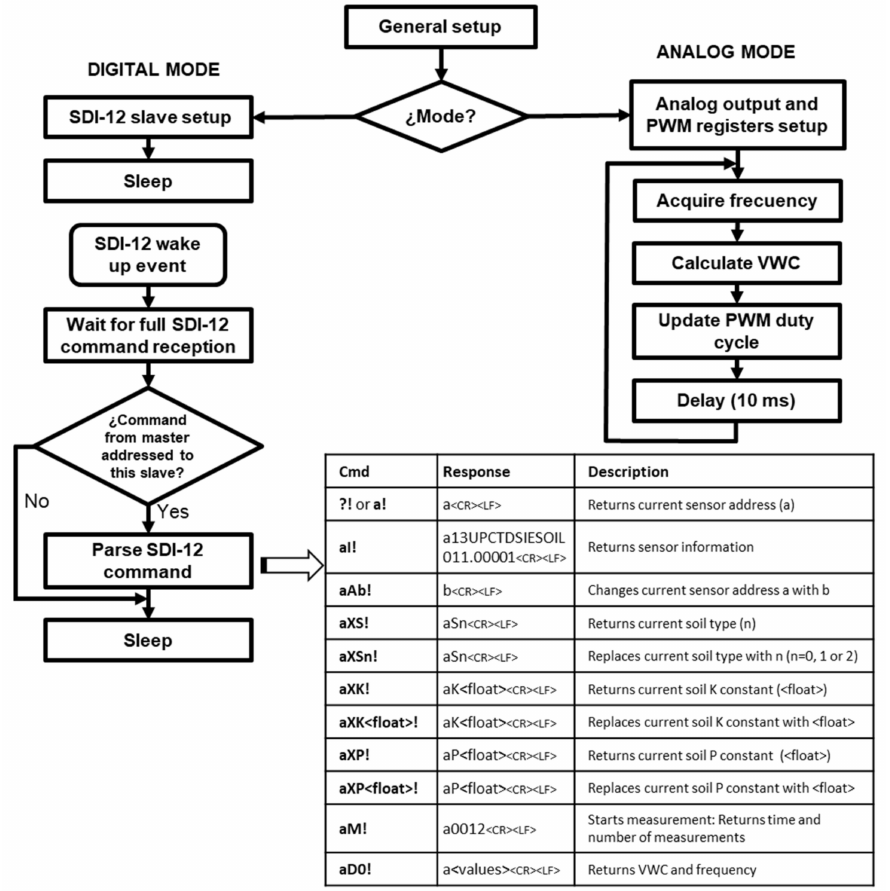
Figure 3. Sensor software